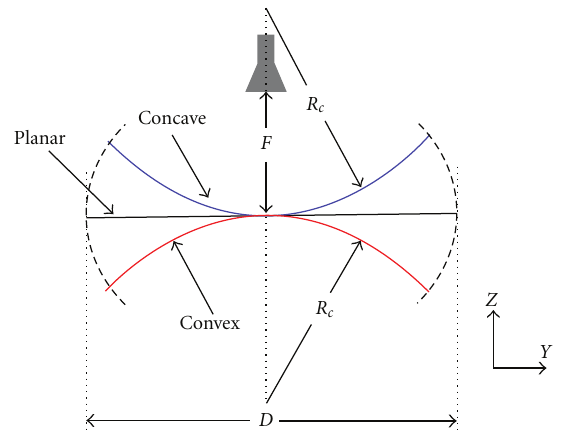
Figure 2: Cross-section of the conformal cylindrical reflectarrays